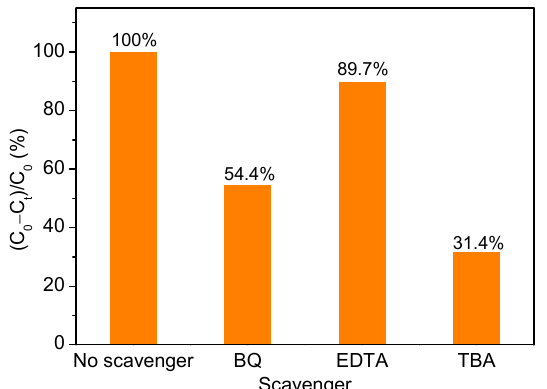
Figure 11. The photodegradation rates of MO by Ag/Bi 2 O 2 CO 3 /α-Bi 2 O 3 after 60 min in the presence of various scavengers. The effects of Bi 2 O 2 CO 3 /α-Bi 2 O 3 and Ag NPs on the efficiency of photoinduced elec- trons and holes separation were investigated by the photocurrent tests, as shown in Figure 12. The photocurrent intensities of the samples follow the order of Ag/Bi 2 O 2 CO 3 /α-Bi 2 O 3 > Bi 2 O 2 CO 3 /α-Bi 2 O 3 > α-Bi 2 O 3 . As demonstrated in the previous research, higher photocur- rent intensity means higher separation efficiency of the photoinduced electron/hole pairs.